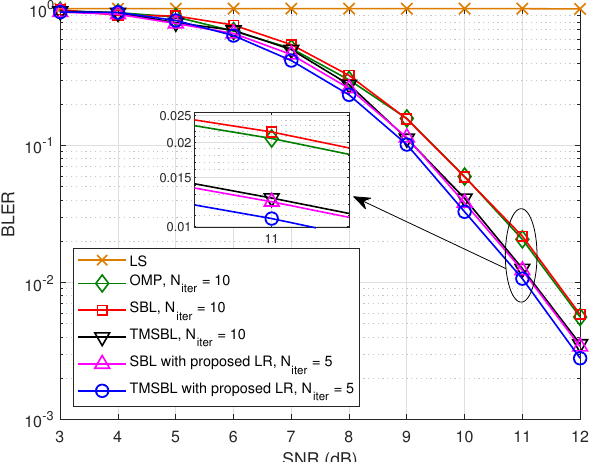
Figure 5. BLER performance versus SNR for 16QAM